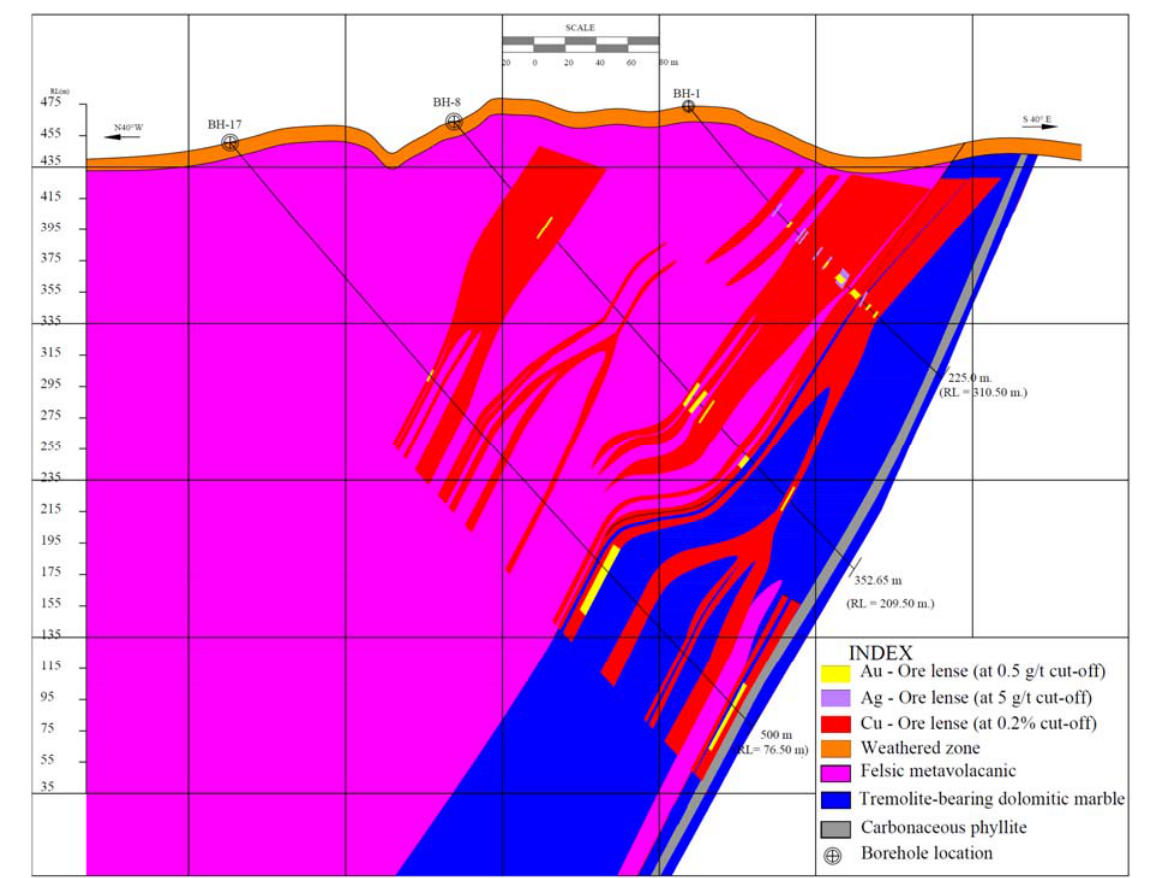
Figure 4. Sectional view of host and ore zones intersected along boreholes in the study area after [52].